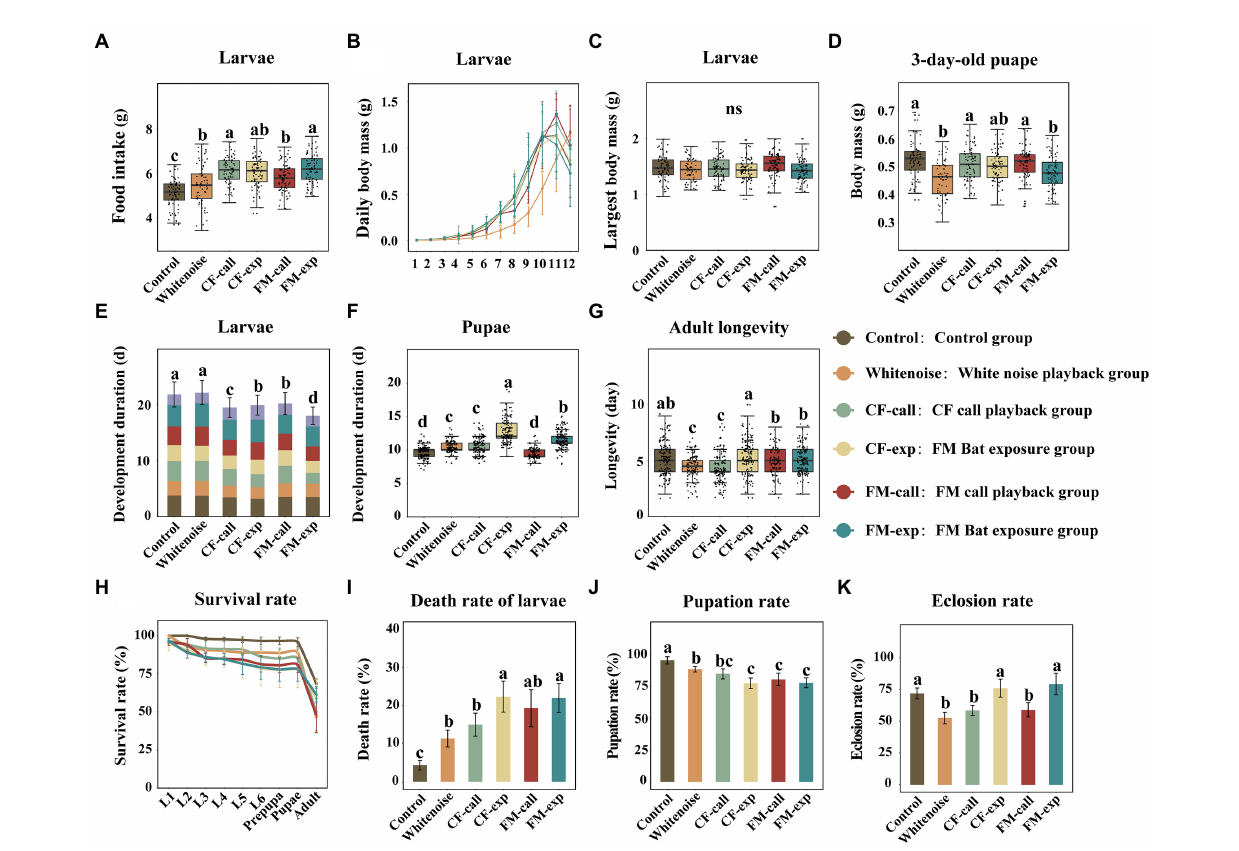
FIGURE 1 Effects of different treatments on the growth and development of S. litura . (A) Food intake of larvae in different treatment groups, (B) diurnal variation in the body mass of the larvae, (C) maximum fresh body mass of the larvae, (D) body mass of 3-day-old pupae, (E) the duration of larval development, (F) the duration of pupal development, (G) longevity of moths, (H) the survival rate at different life stages, (I) the death rate of larvae, (J) the pupation rate of larvae, and (K) the eclosion rate of pupae. The data are expressed as the mean ± SD. Different colors represent data from different treatment groups. The different letters on the bar and box plots indicate significant differences between treatment groups (Tukey’s test, p < 0.05); ns indicates no significant difference between